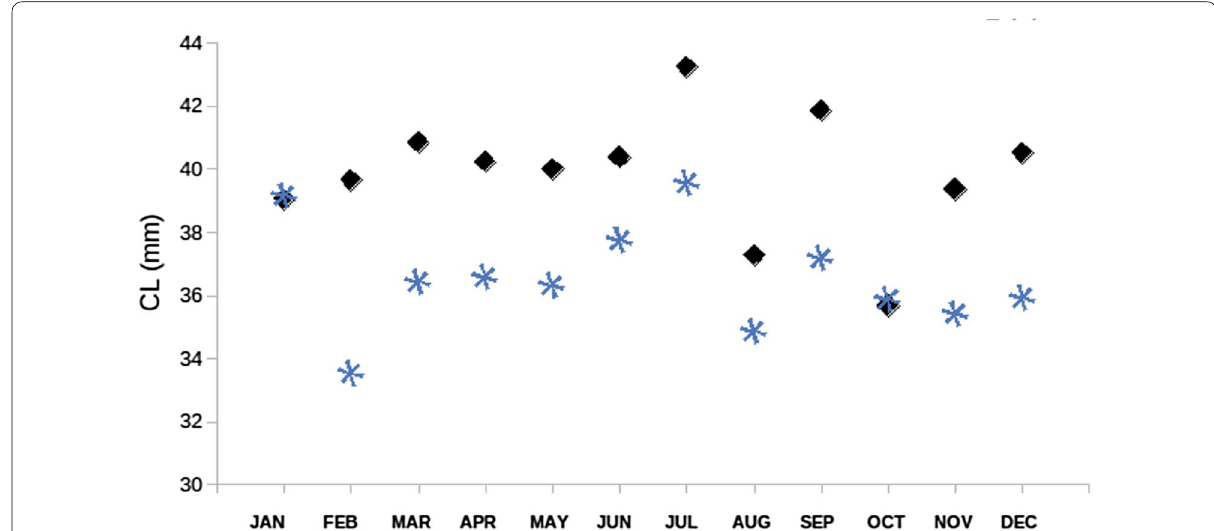
Fig. 3 Plot of mean Carapace Length per month for each sex. Asterisks denote females and diamond-shape males,